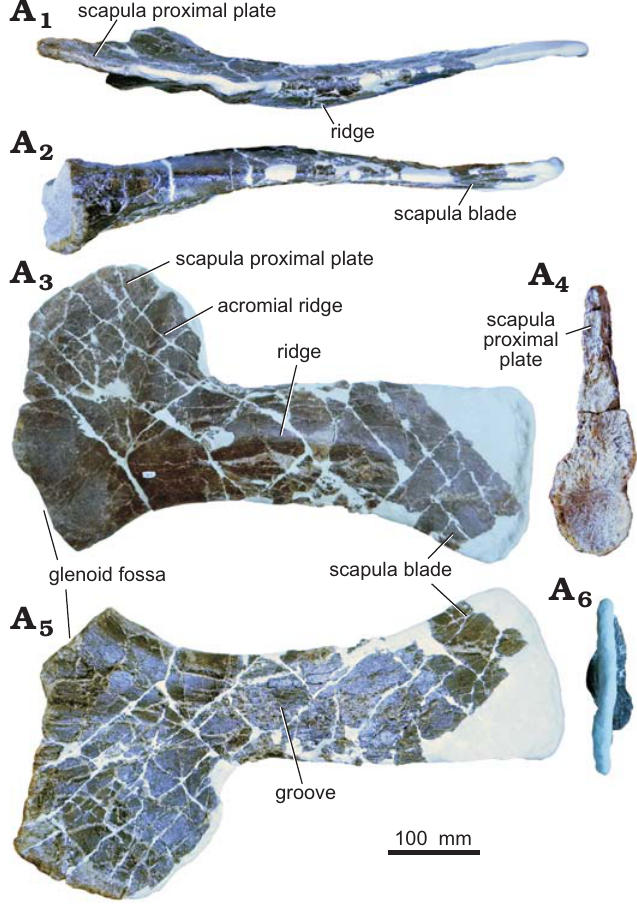
Fig. 13. Left scapula of stegosaur GPDM 178, near Giffen, Cascade County, Montana; in dorsal (A 1 ), ventral (A 2 ), lateral (A 3 ), anterior (A 4 ), medial (A 5 ), and posterior (A 6 )